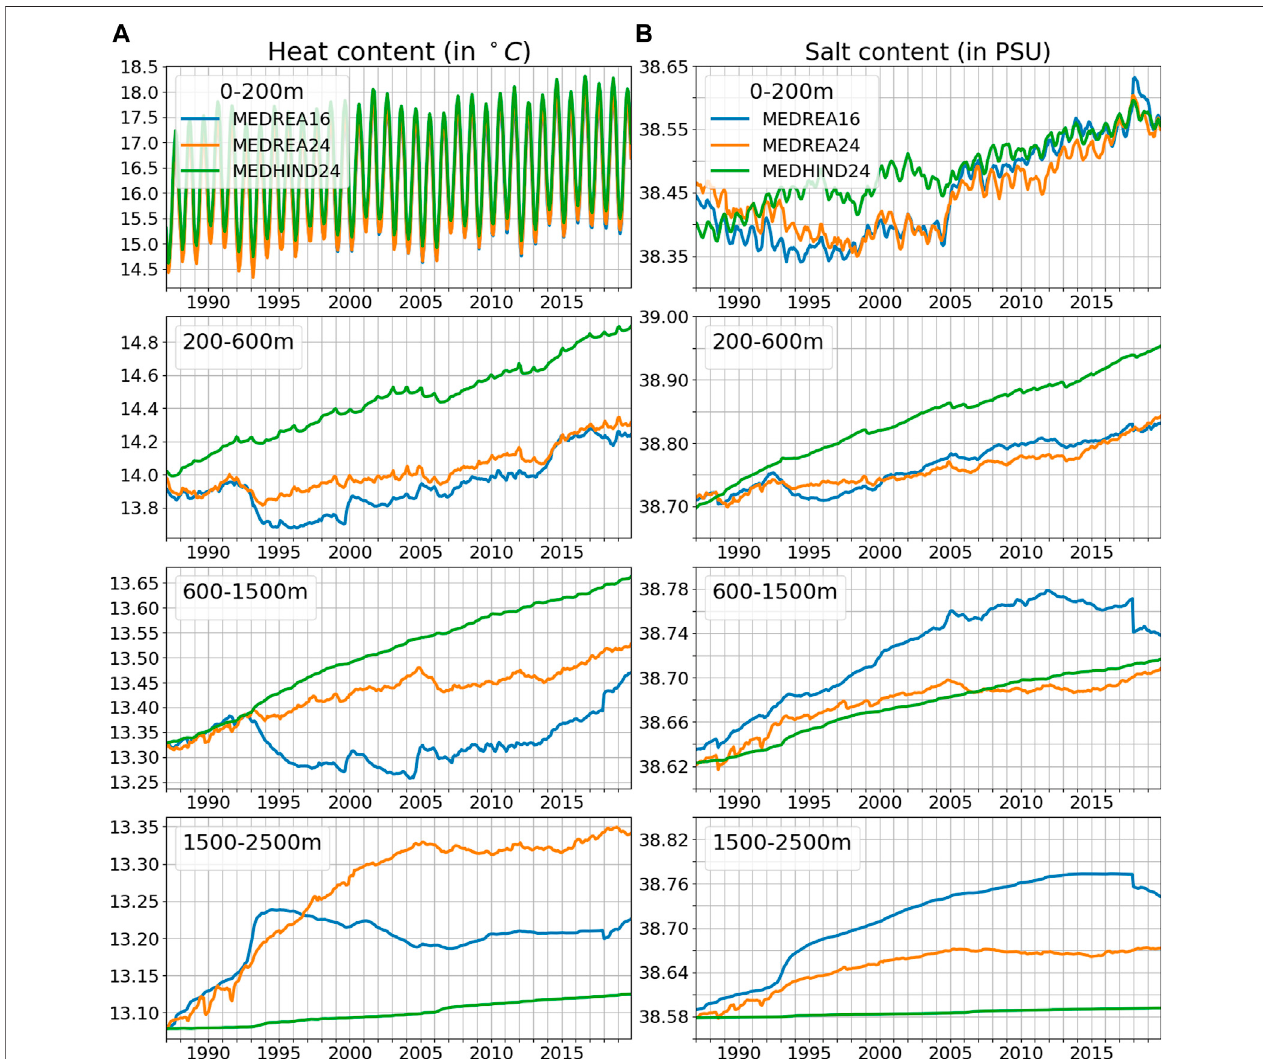
FIGURE9| Timeevolutionofheatcontent[ (A) ,in ° C ]andsaltcontent[ (B) ,inPSU]indifferentlayersforbothreanalysesandthehindcast.Theseareaveragedover the whole Mediterranean Sea.